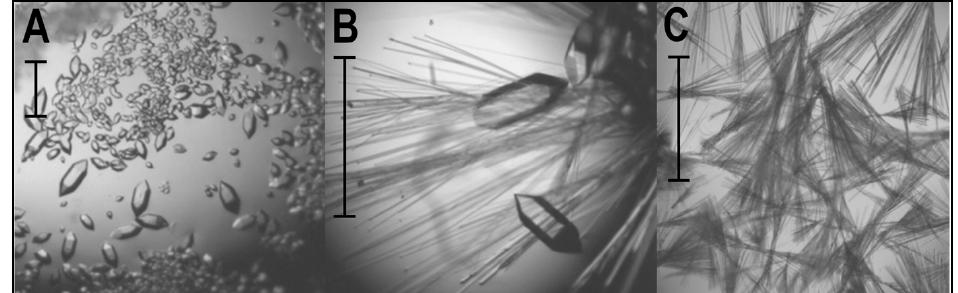
Figure 1. PSD95 ‐ PDZ3 grown in 30% PEG 4000, 0.2 M ammonium sulfate, 0.1 M sodium acetate, pH ( A ) 3.7, ( B ) 4.0, ( C ) 5.0. The crystals show different morphologies: the diamond crystals belong to the trigonal space group P3 1 12. The long needle crystals belong to the orthorhombic space group P2 1 2 1 2 1 and monoclinic space group P2 1 . A 200 μ m bar is shown in each photograph to indicate the crystals’ size.